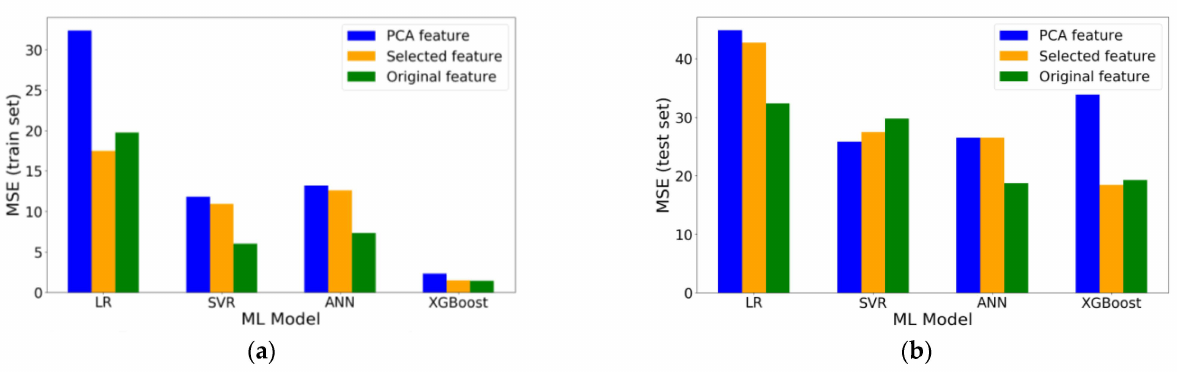
Figure 15. R-square of different ML models with different features: ( a ) training set and ( b ) test set.